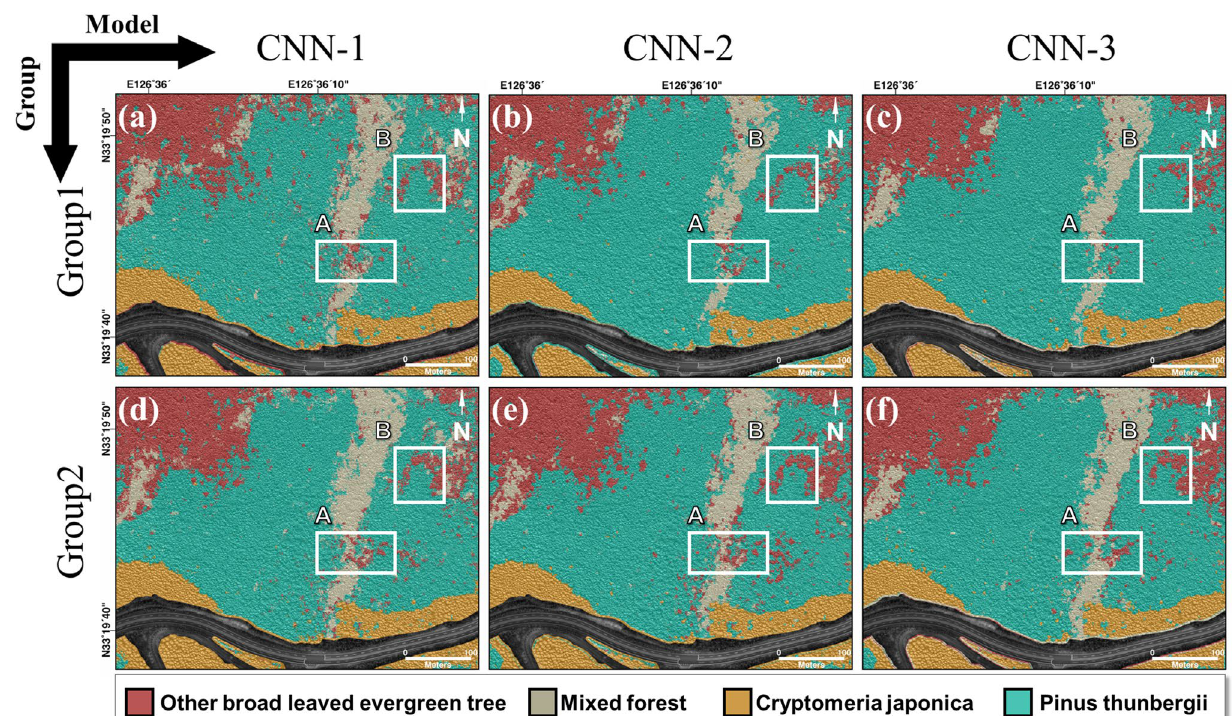
Figure 7. Forest tree species predicted maps: ( a – c ) CNN-1, CNN-2, and CNN-3 models in Group 1, respectively; ( d – f ) CNN-1, CNN-2, and CNN-3 models in Group 2, respectively; Box A represents the boundary of Pinus thunbergii and the mixed forest and Box B represents the boundary of other broad-leaved evergreen trees and Pinus thunbergia.